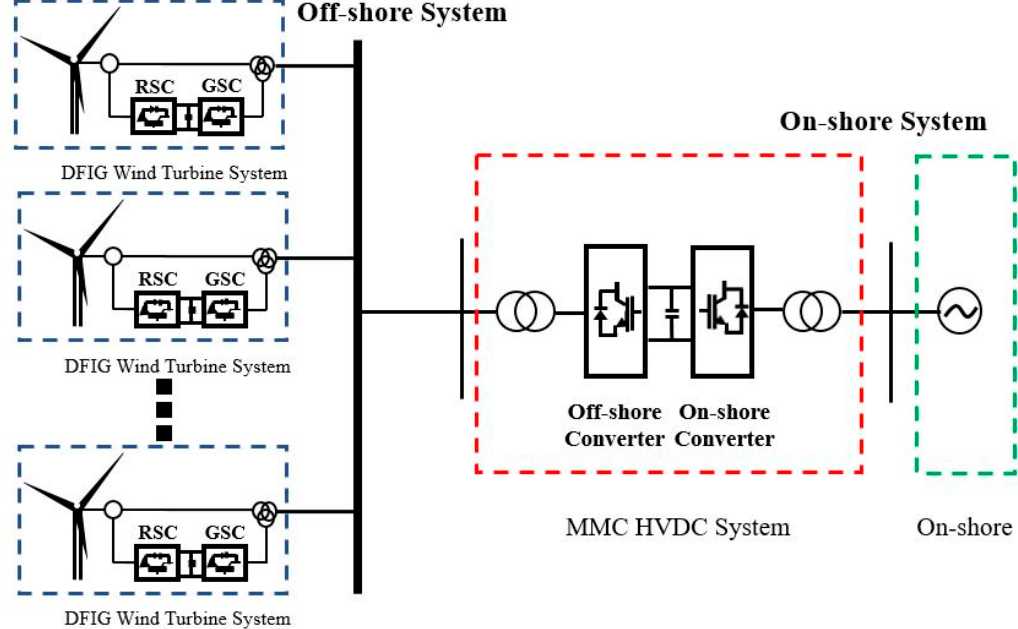
Figure 1. O ff -shore doubly-fed induction generator (DFIG) wind farm with Figure 1. Off-shore doubly-fed induction generator (DFIG) wind farm with MMC.